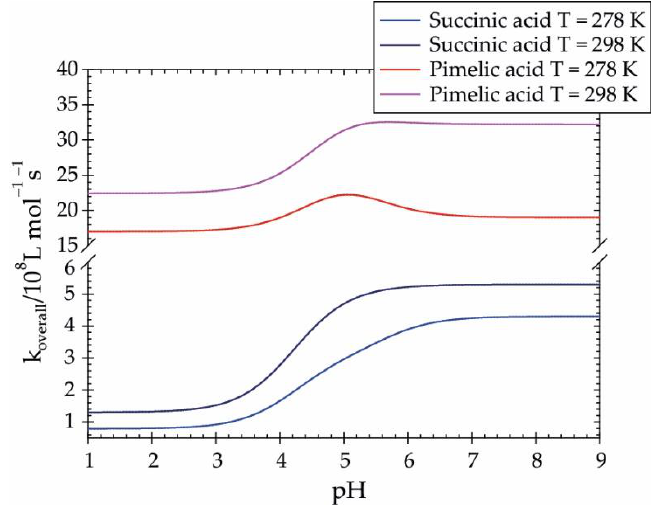
= 278 K and T = 298 overall ) as function of the pH at T